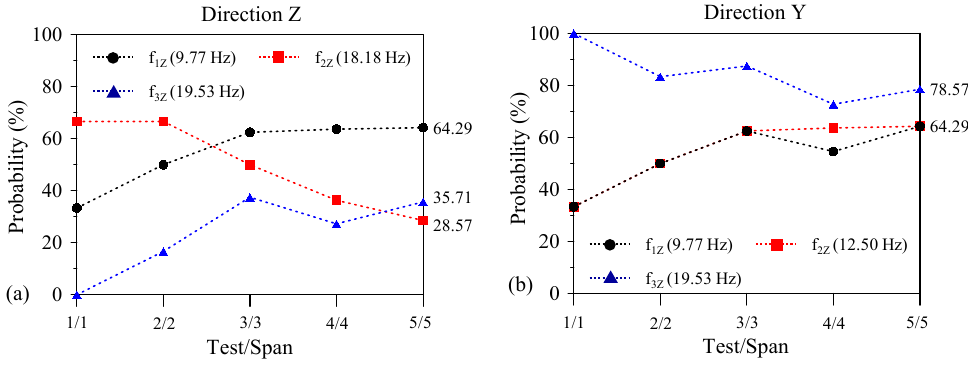
Figure 11. Dependence of the probability of appearance of the first three frequencies identified in both directions depending on the number of tests/span. ( a ) Direction Z, ( b ) Direction Y.